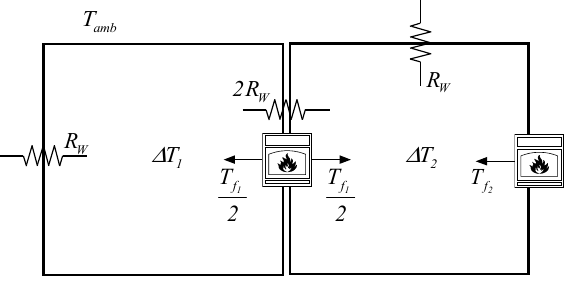
Figure 3. Test case system scheme.